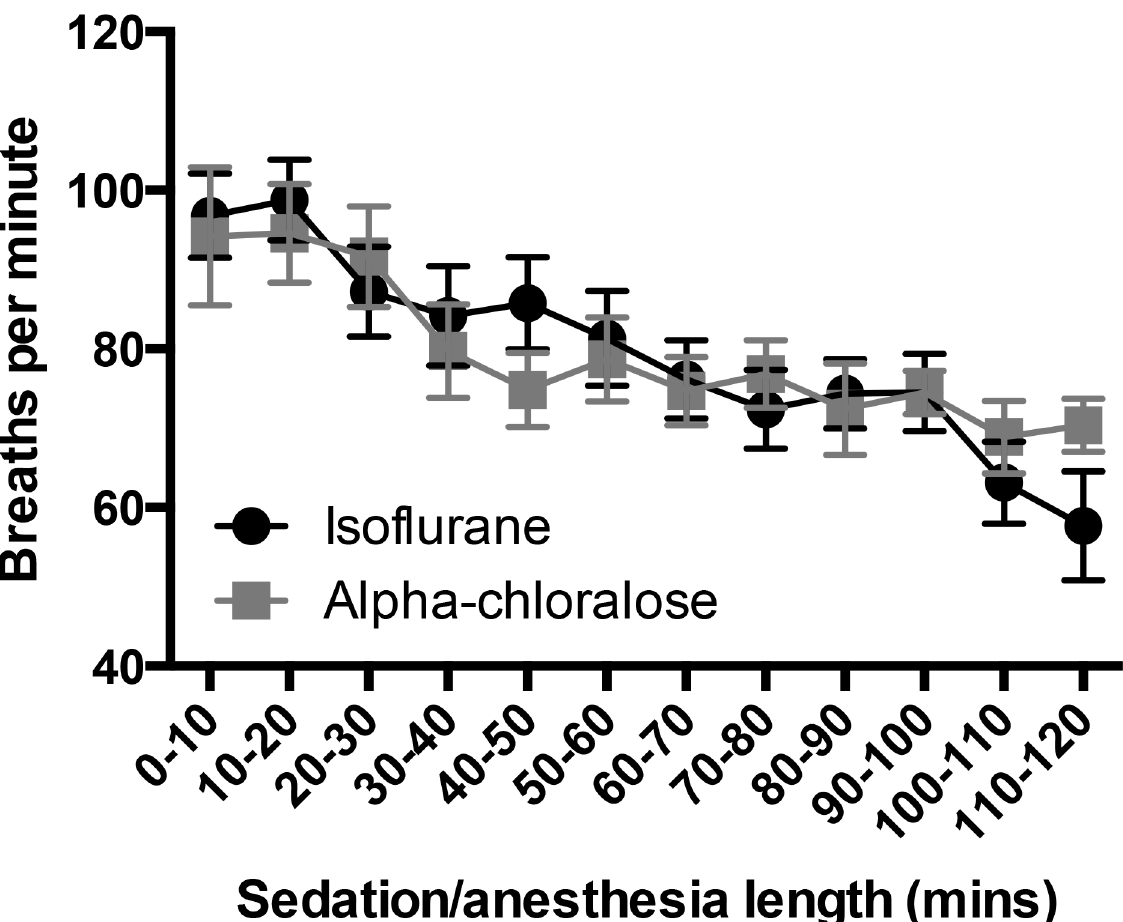
Fig 1. Breathing Rate decreases over time during prolonged anesthesia. There were no group differences between isoflurane and alpha chloralose-treated mice at any time (F (1,386) = 0.001, p = 0.97), but there was a significant overall drop in breathing rates for both groups (F (11,386) = 5.68, p < 0.0001, n = 7 – 24 per time